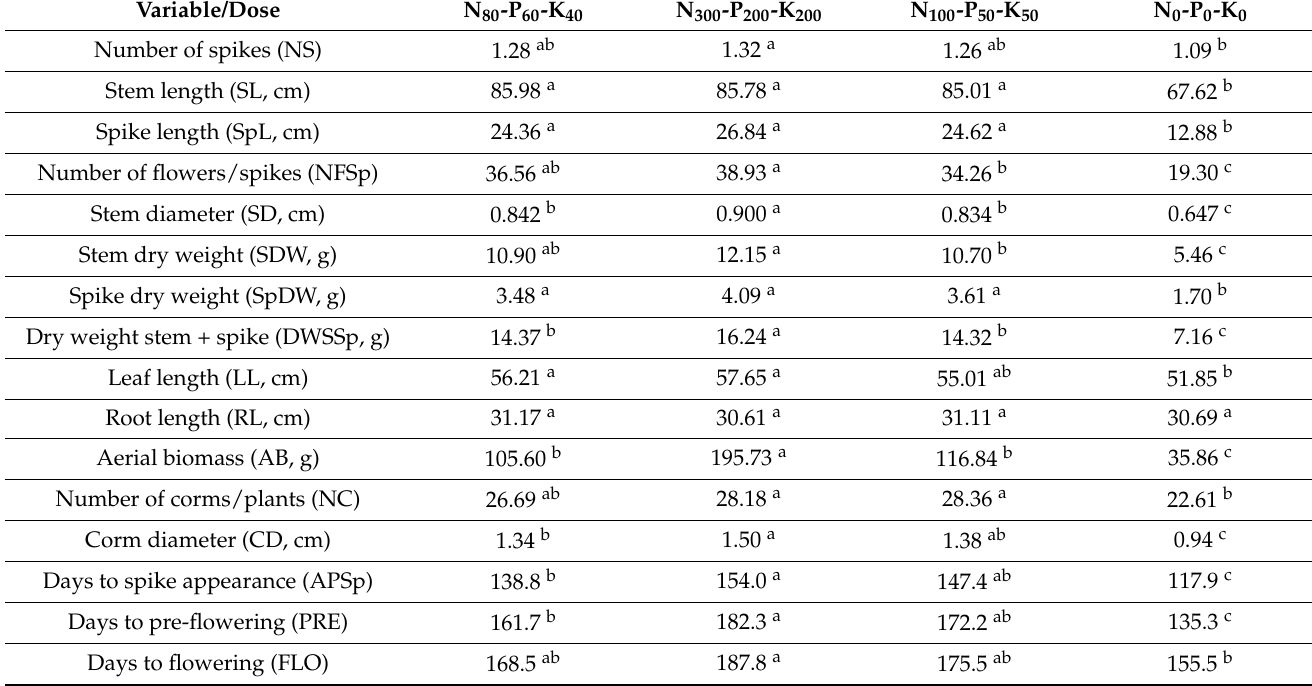
Table 7. Tuberose spike, stem and leaf characteristics, and days to appearance of spike, to pre- flowering and to flowering with different doses of